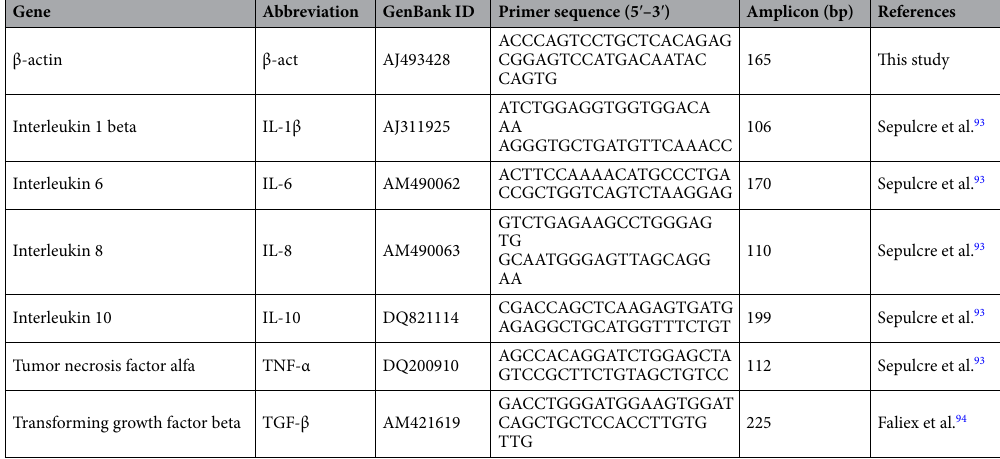
Table 3. Primer sequences used for gene expression analyses of immune